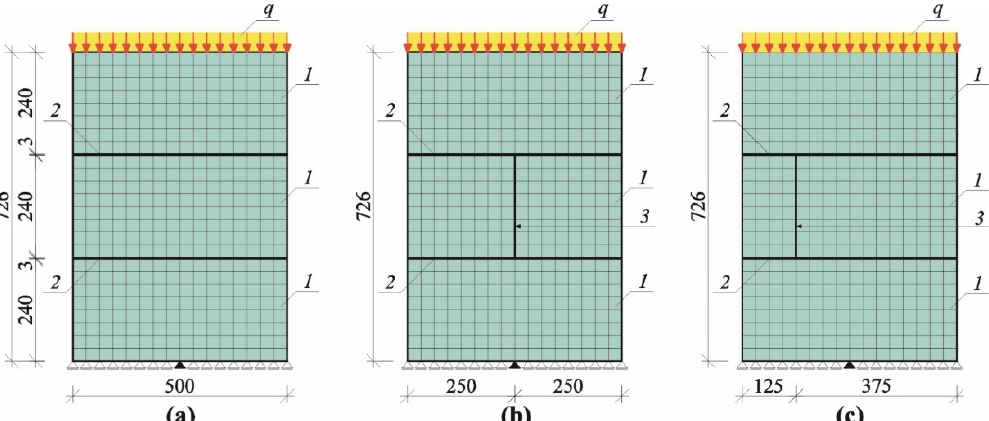
Figure 17. FEM models for the test walls: ( a ) models of series I without head joint, ( b ) models of series II with head joint at mid-length of the element, ( c ) models of series III with head joint at 1/4 length the masonry unit 1 —masonry unit; 2 —mortar; 3 —unfilled head joint.